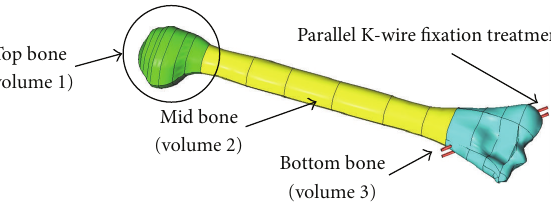
Figure 3: Solid model of humerus bone fracture treatment with parallel K-wires.